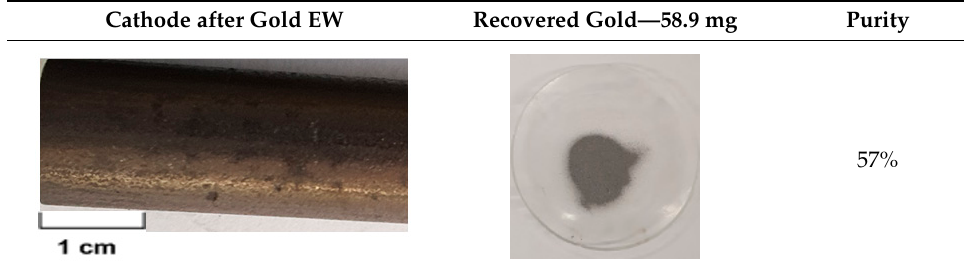
Table 8. Photographic aspect of gold deposit on graphite chatode and purity. Cathode after Gold EW